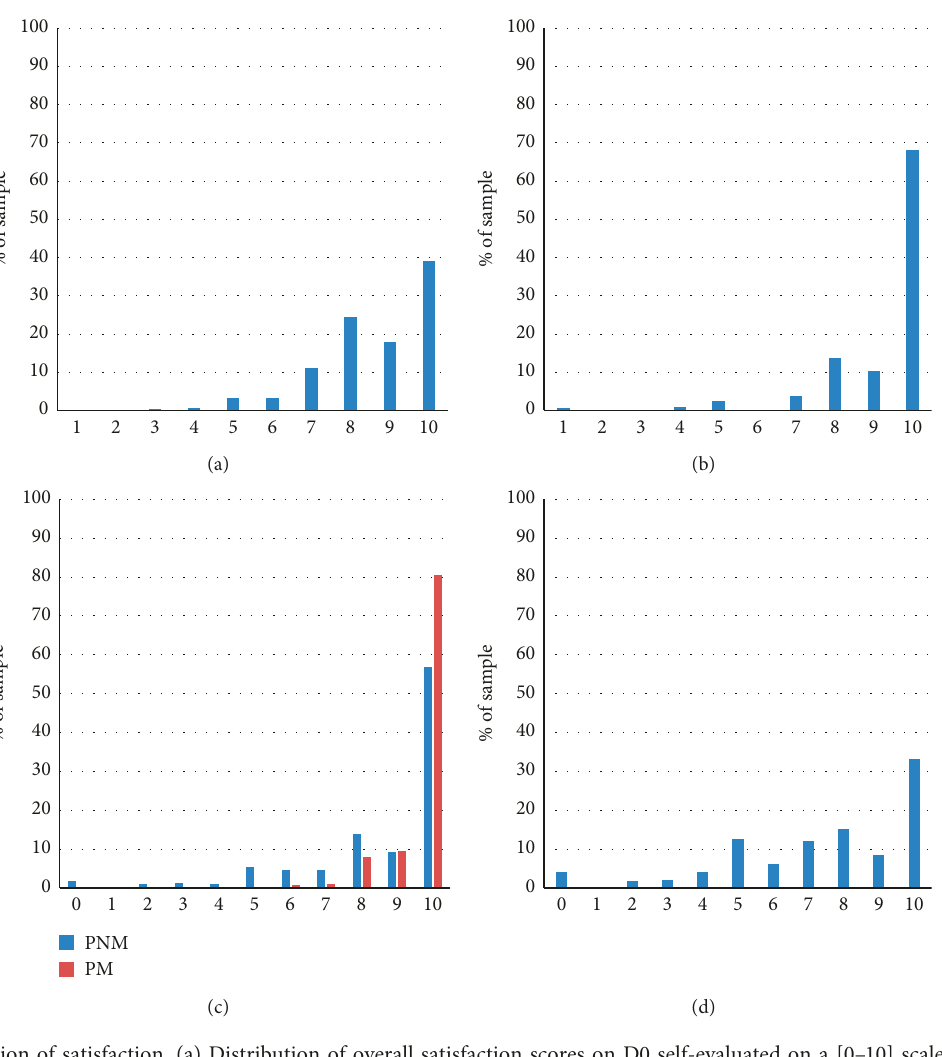
Figure 6: Evaluation of satisfaction. (a) Distribution of overall satisfaction scores on D0 self-evaluated on a [0–10] scale (abscissae) (b) Distribution of scores of perception of quality of medical treatment and information. (c) Distribution of scores of politeness and availability of medical (PM) and nonmedical (PNM) staff. (d) Perception of waiting time in the